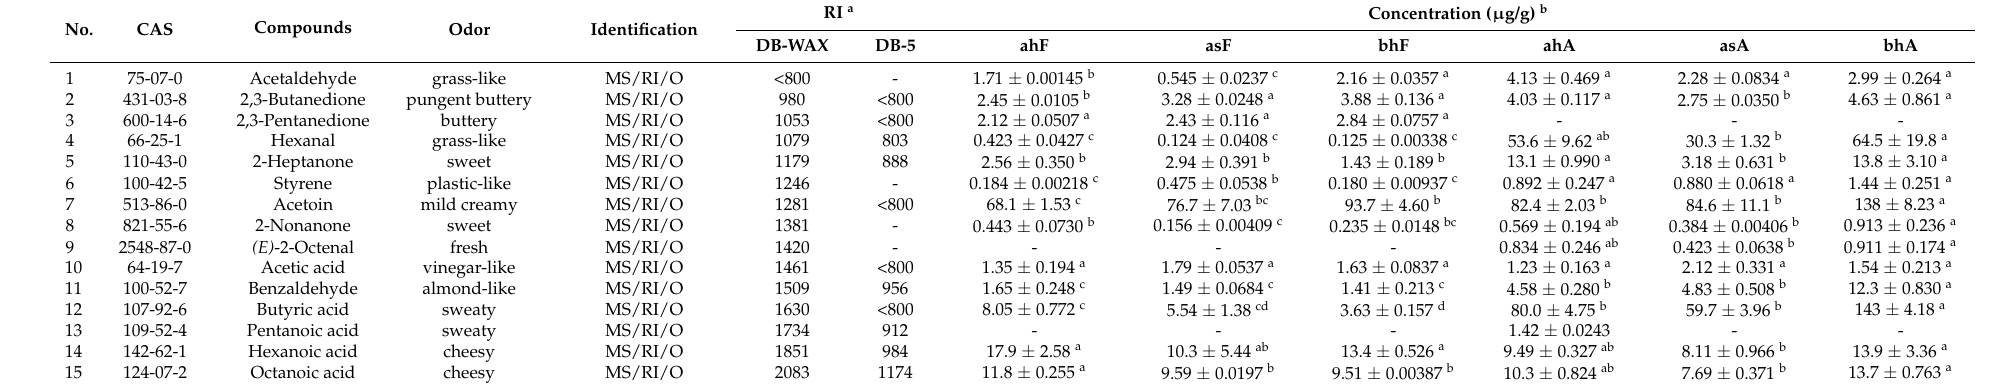
Table 2. Odor-active compounds determined in six pasteurized yogurt samples by